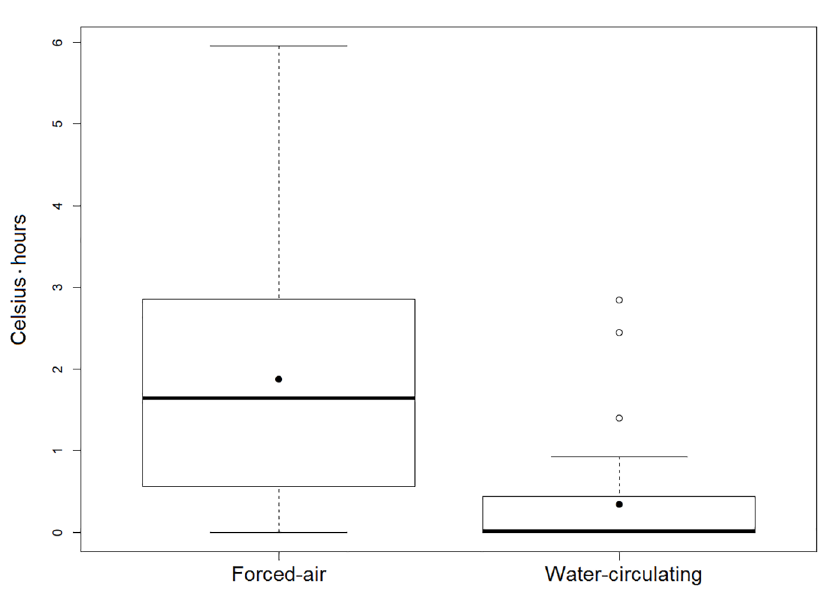
Fig 3. Degree-hours below 36 degrees Celsius. Area between mean temperature versus time curve and below36.0 degreesCelsiusfor patients warmed with forced-airand water-circulating devices. The median areas under 36.0 degreesCelsius were 0.0 and 1.6 degree-hours for the forced-airand water-circulating groups, respectively.The durationand magnitude of hypothermia was significantly greater in the forced-air warminggroup (p <